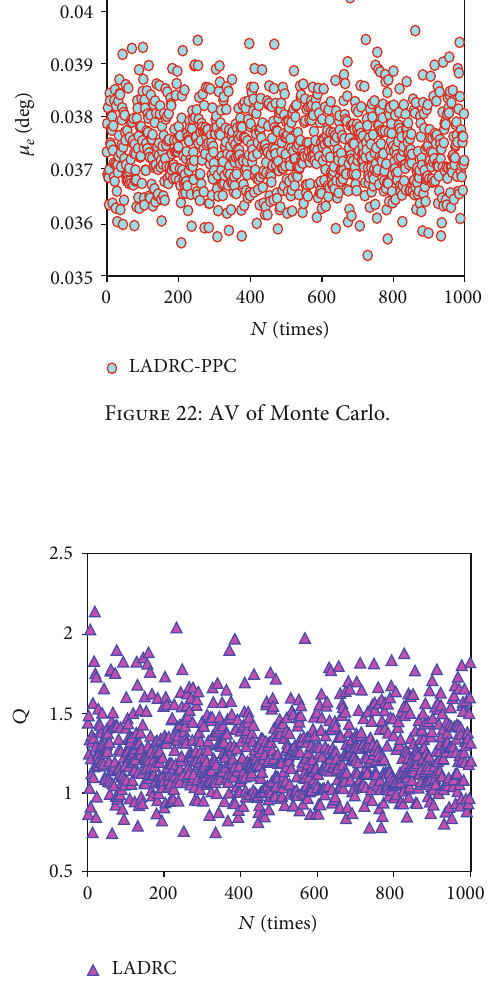
Figure 23: ACC of Monte Carlo.